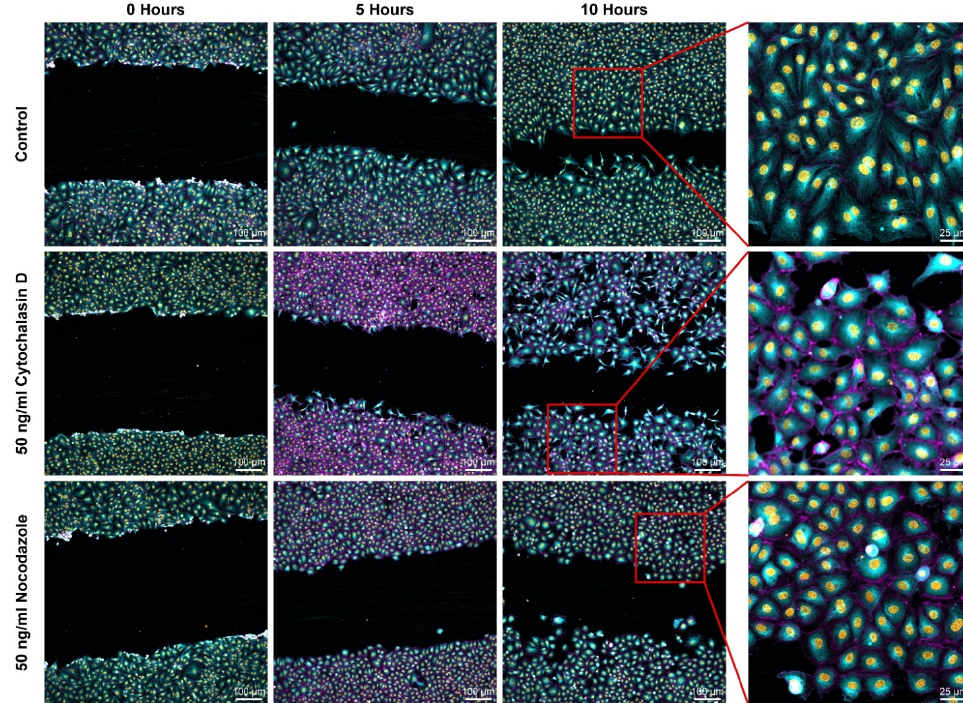
Figure 2. Wound healing assays for cytoskeletal disruptions and control. Stained actin is presented in purple, tubulin stains are shown in green, and then nuclear counterstain is provided in yellow. To better view single cell morphology, 4 X zoom-in of the field of view is provided for each condition.